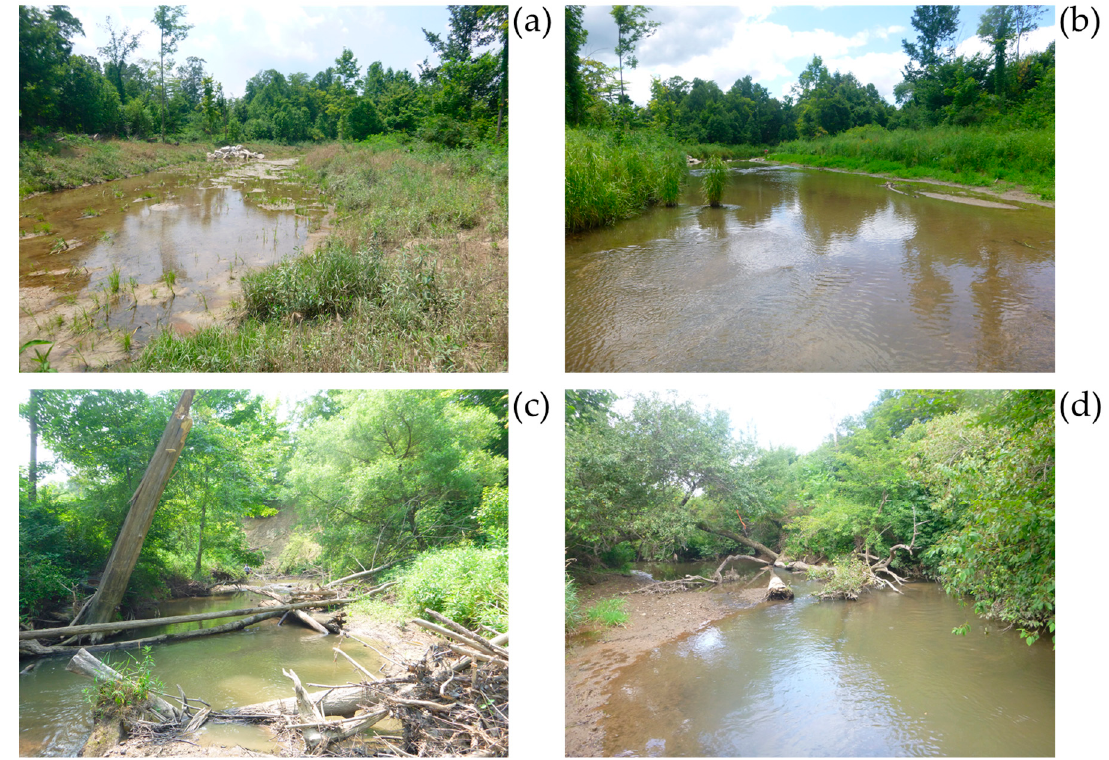
Figure 2. Photographs of sites showing ( a ) the newly excavated channel prior to diversion of water (2013); ( b ) the newly excavated channel following diversion (June 2014); ( c ) the upstream control site; and ( d ) a site downstream of the new channel.